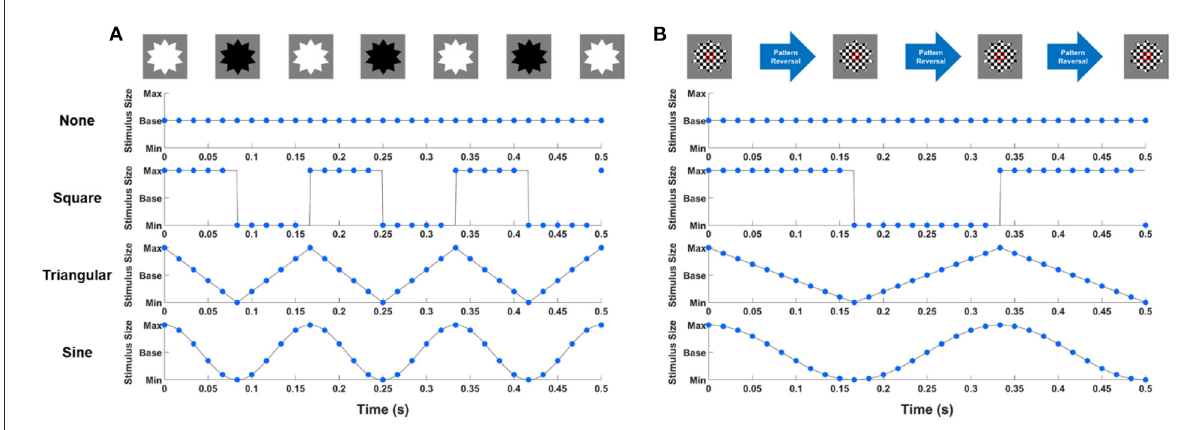
FIGURE1 Examples of (A) FS-based hybrid visual stimuli and (B) PRS-based hybrid visual stimuli when the stimulation frequency was 6Hz. Blue circles indicate the stimulus size presented to participants considering the refresh rate of the LCD monitor.